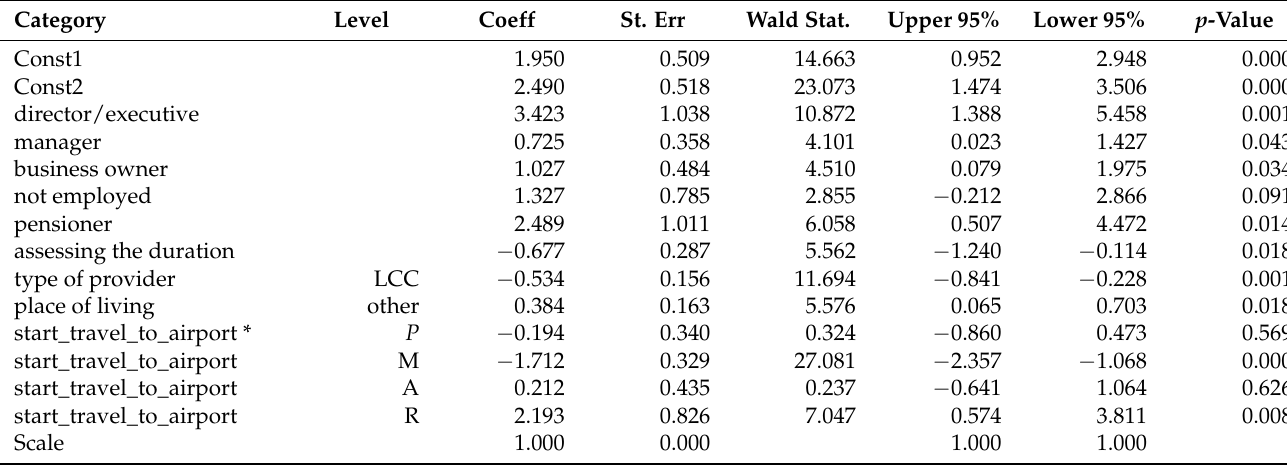
Table 8. Detailed results for ordered logit model presented in Table